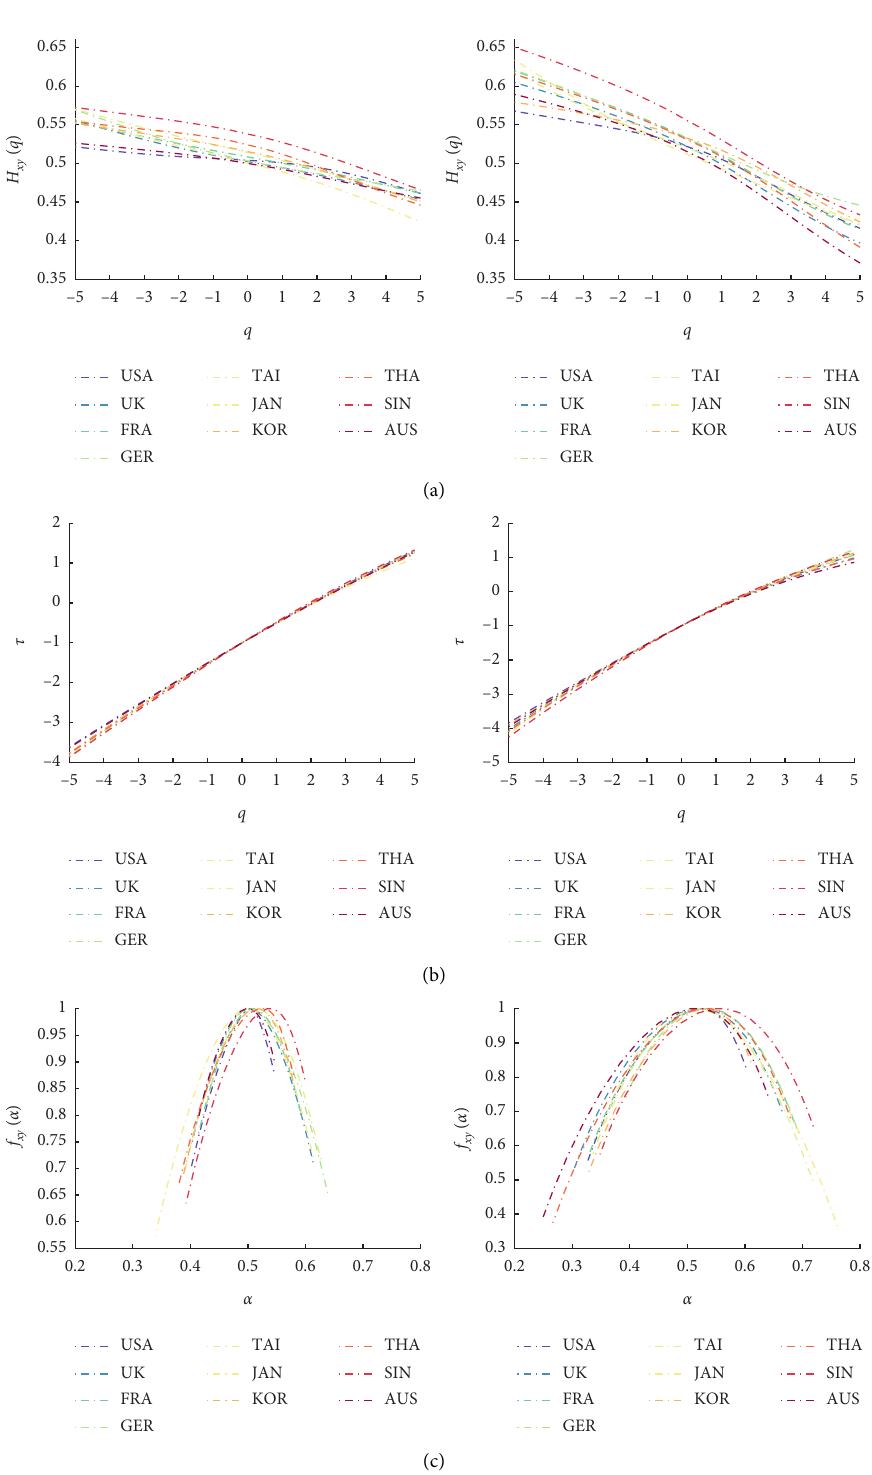
Figure 3: MF-DCCA analysis of AHA, AHH, and the other ten pairs for the preperiod. (a) Generalized Hurst exponent as a function of ( q ). (b) Multifractal exponent as a function of ( q ). (c) Singularity